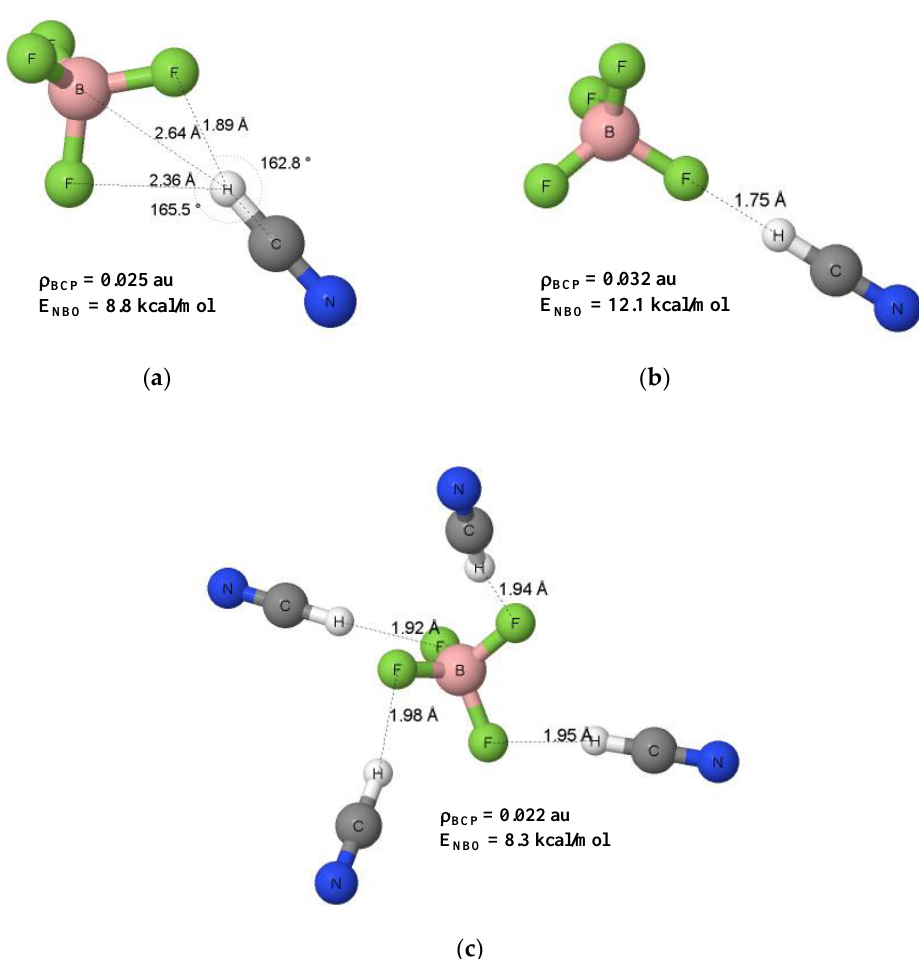
Figure 6. The nonlinear ( a ) and linear ( b ) configurations of the BF 4 − ... HCN complex, the BF 4 − ... (HCN) 4 cluster ( c ) is also presented; a few parameters are shown in this figure, such as distances, angles, electron densities at BCPs, ρ BCP ’s, and orbital–orbital overlap energies, E NBO